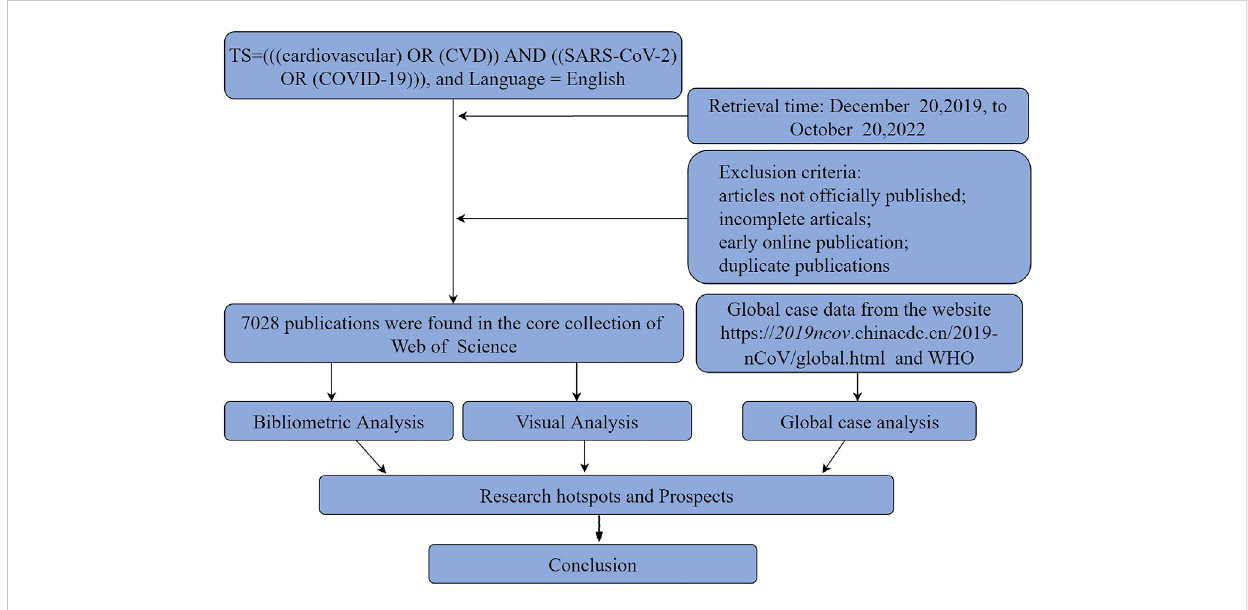
Flowchart of data collection and research